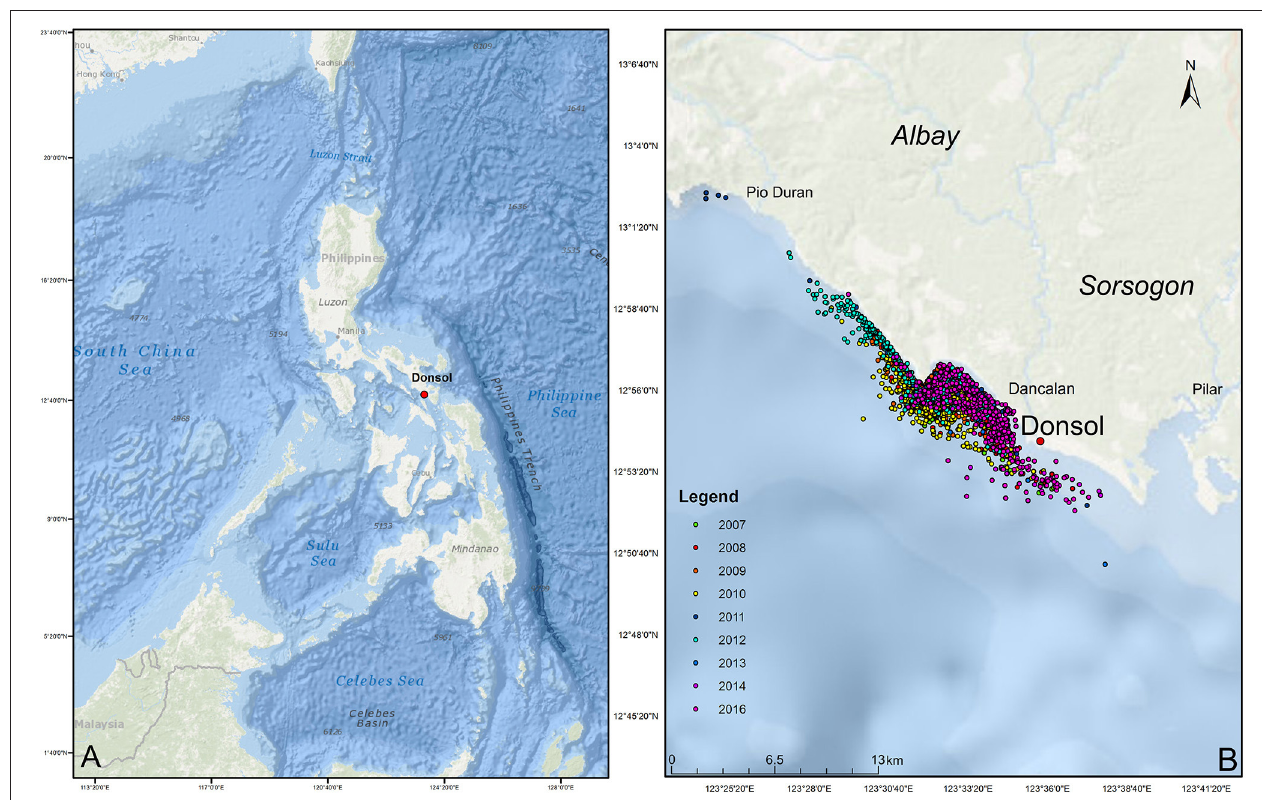
FIGURE 1 | Map of the Philippines (A) and study site (B) . Dots represent individual whale shark sightings during surveys between 2007 and 2016, whereas colors represent the different years in which they were